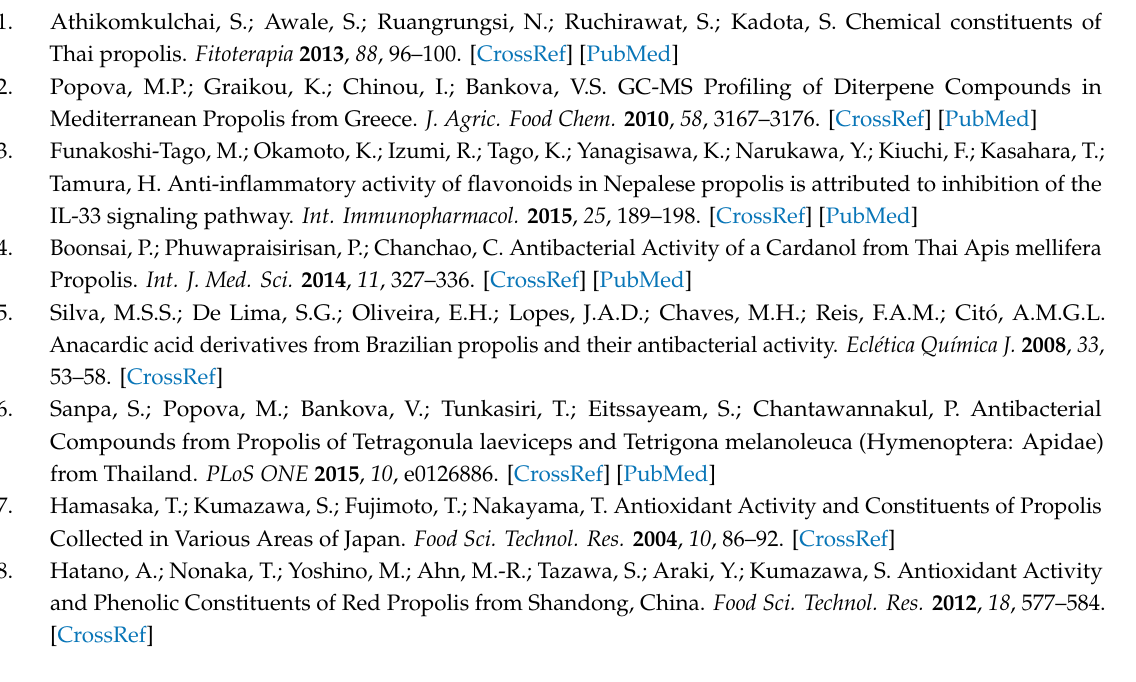
Supplementary Materials: The following are available online. Supplementary Table S1. Primer pairs used for qRT-PCR expression analysis; Supplementary Table S2. Partial DEPs of P. notatum in response to EEP; Supplementary Table S3. DEPs of P. notatum in response to propolis; Supplementary Figure S1. COG functional categories of